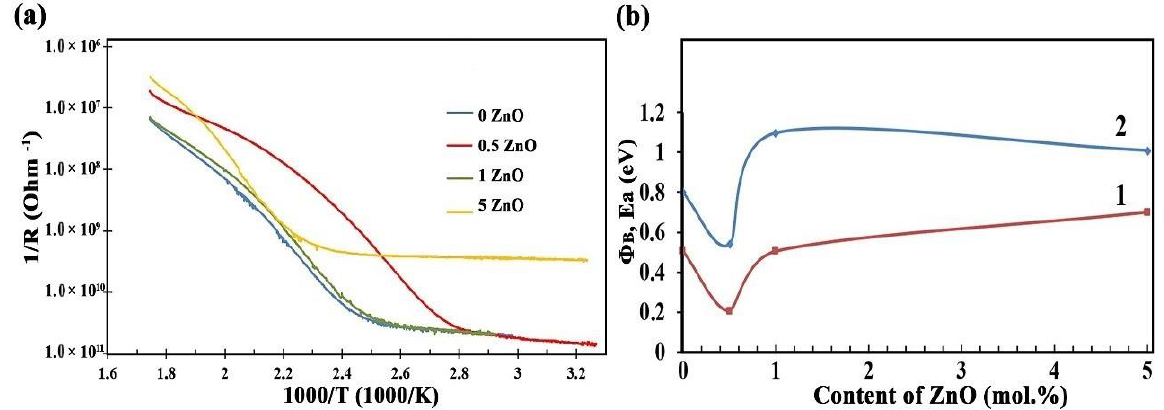
Figure 9. ( a ) Temperature dependence of gas sensors’ reverse resistance and ( b ) dependences of the activation energy of the conductivity E a (curve 1) and the potential barrier (curve 2) of ZnO-SnO 2 films on the content of ZnO.